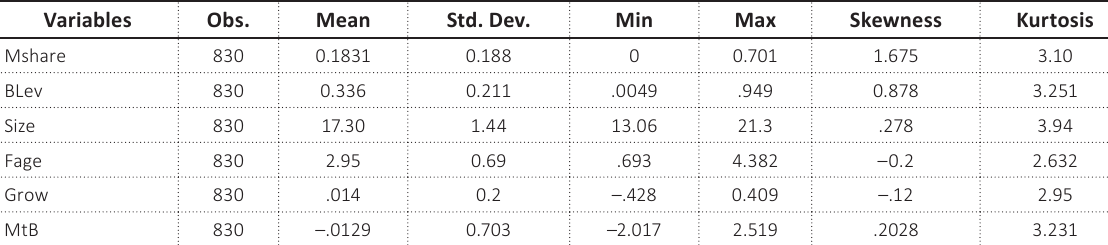
Table 2. Descriptive statistics and normality tests